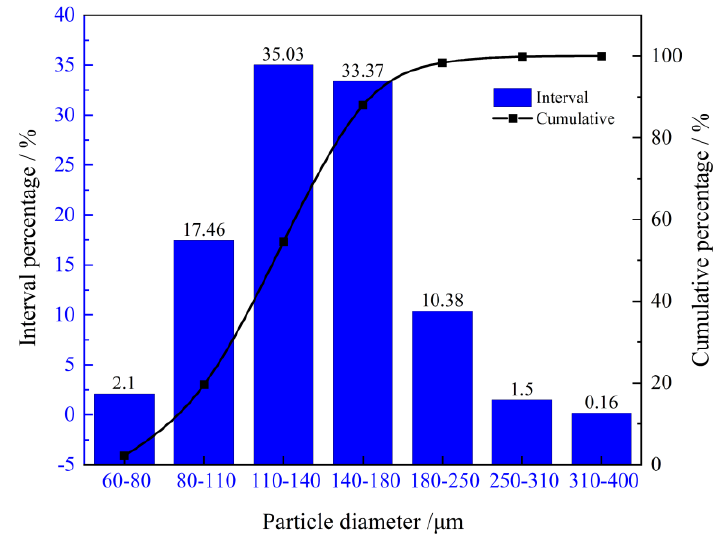
Figure 3. Particle size distribution of milled nickel slag.